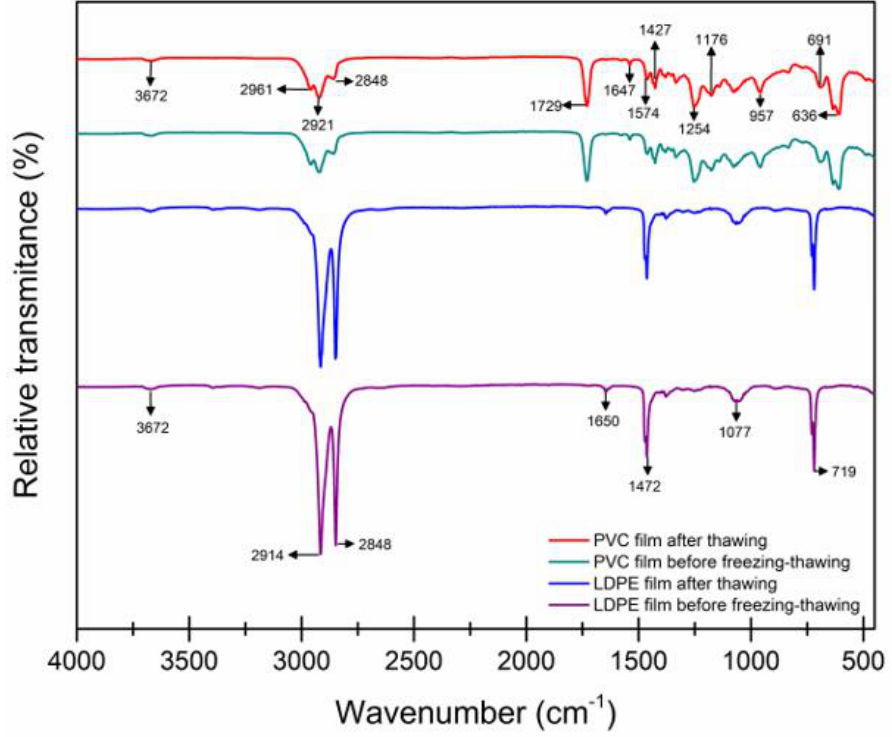
Figure 3. Infrared spectrum of a commercial low-density polyethylene (LDPE) and polyvinyl chloride (PVC)